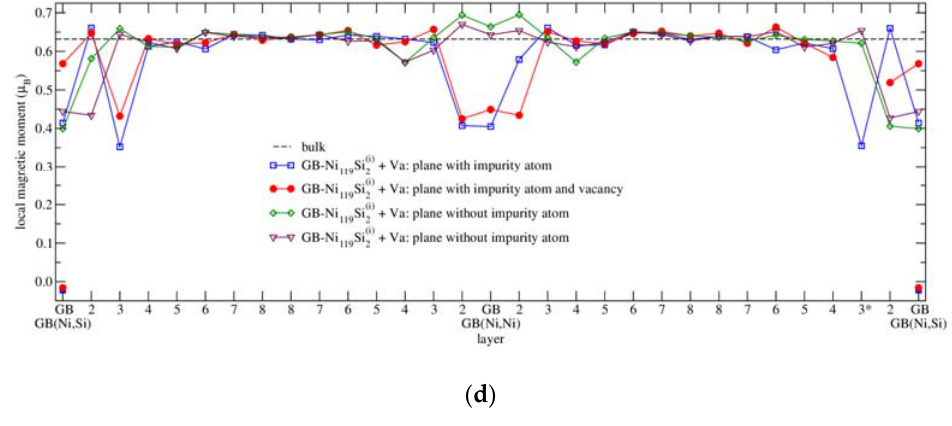
Figure 9. Magnetic moments of Ni atoms in supercells with a GB, an impurity and a vacancy: ( a ) GB ‐ Ni 119 +Va L2 , ( b ) GB ‐ Ni 117 Al 2(s) +Va L2 , ( c ) GB ‐ Ni 117 Si 2(s) +Va L2 , ( d ) GB ‐ Ni 119 Si 2(i) +Va L3 . The superscripts L2 and L3 denote the position of the vacancy in the second and third layer, respectively. * denotes the layer with the vacancy. The full points mark the magnetic moments of impurities. The dashed line shows the magnetic moment of fcc bulk Ni of 0.632 μ B calculated in this work. For a better demonstration of results in Figures (b–d), the plane with impurity atom is always presented so that the impurity is on the edges of the figures. This was achieved by the shift of ½ of the lattice parameter b of lines representing the results of some planes with impurities (the middle plane of GB ‐ Ni 118 Al 2(s) and GB ‐ Ni 118 Si 2(s) or the second plane of GB ‐ Ni 120 Si 2(i) ) and one without impurity (the middle plane of GB ‐ Ni 120 Si 2(i) ).